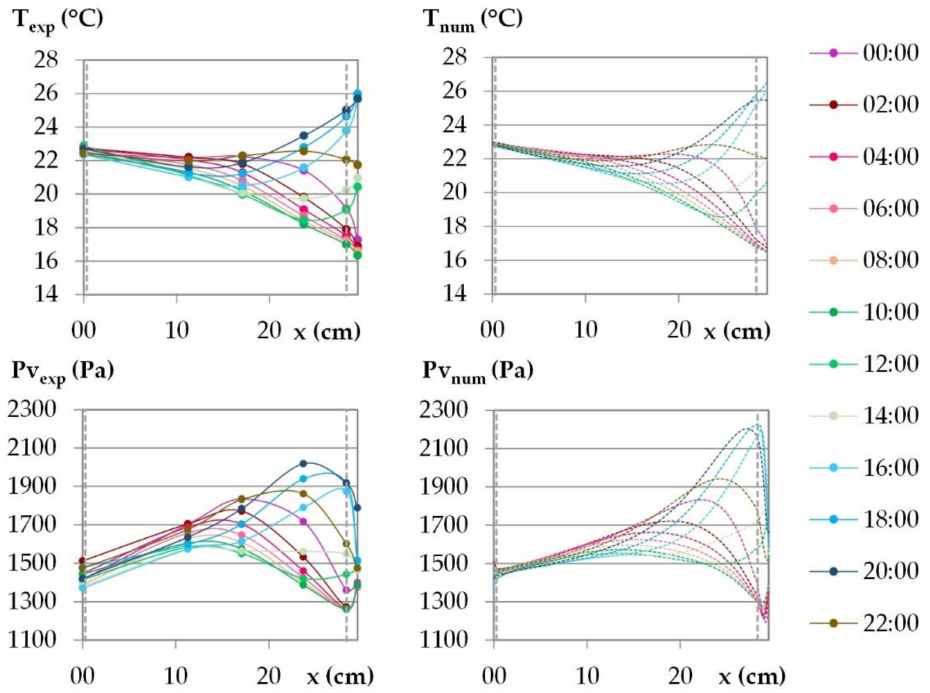
Figure 16. Temperature and vapor pressure profiles during the last day of the dynamic solicitation phase for the climate of Toulouse. Points: experimental values; dotted lines: numerical